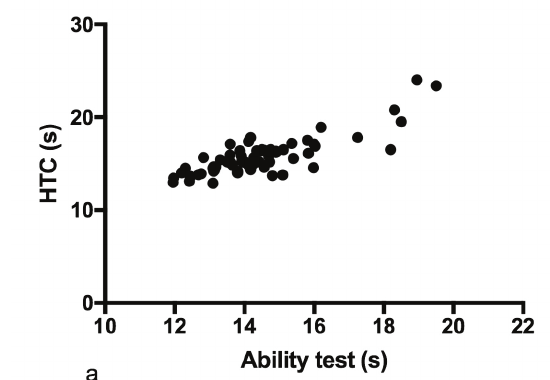
FIGURE 1. Correlation analysis between PAT and HTC (p<0.0001). All data are in seconds.